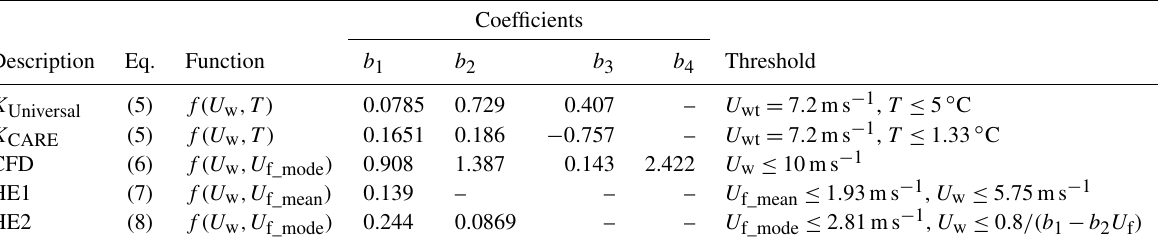
Table 1. Unshielded Geonor T-200B3 precipitation gauge collection efficiency transfer function coefficients for solid and mixed precipitation with 30min scalar mean wind speed U w at gauge height for K Universal function with wind speed and air temperature T dependence, with constant value above wind speed threshold with Kochendorfer et al. (2017a) coefficients; K CARE function with wind speed and air temper- ature dependence, with constant value above wind speed threshold; present study CFD model with dependence on wind speed and mode hydrometeor fall velocity U f_mode ; HE1 model with dependence on wind speed and mean hydrometeor fall velocity U f_mean threshold; and HE2 model with wind speed and mode hydrometeor fall velocity dependence and mode hydrometeor fall velocity threshold.